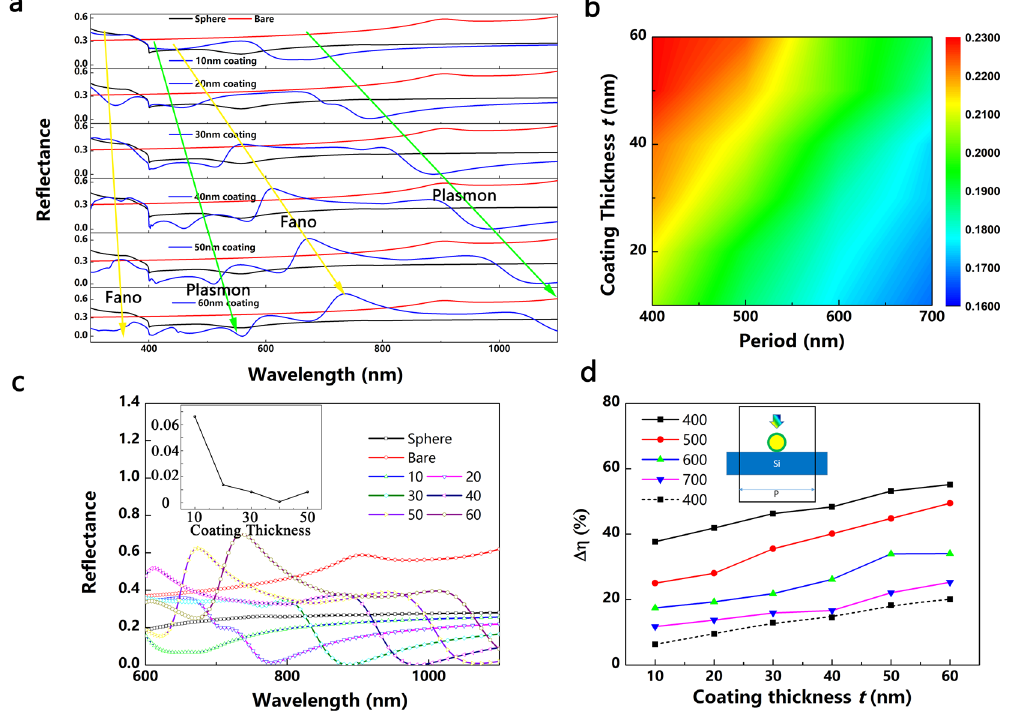
Figure 4. Optical properties and ultimate efficiencies of core-shell nanoparticles with different coating thickness t (Au core/dielectric shell) placed on the front side of a 2 μ m thick Si substrate with different period ( P ). The inner Au core is 120 nm and n is set as 3.4. ( a ) Reflectance spectra of a flat thick Si (2 μ m, bare), a 120 nm Au sphere and core-shell nanoparticles on the 2 μ m thick Si as a function of wavelength, the P is set as 400 nm. ( b ) Ultimate efficiency of core-shell nanoparticles on the 2 μ m thick Si. ( c ) Magnified reflectance spectra of a 2 μ m thick Si, a 120 nm Au sphere and core-shell nanoparticles on the 2 μ m thick Si at long wavelength region; the inset illustrates the minimum reflectance of the 2 μ m thick Si with core-shell nanoparticles locating on the surface. ( d ) Differential efficiency ∆ η between the core-shell nanoparticles on a 2 μ m flat Si and a 2 μ m flat Si without nanoparticles. The dashed line is the differential value of efficiency between the core-shell nanoparticles on a 2 μ m thick Si and a 120 nm Au sphere on a 2 μ m thick Si and the P = 400 nm; the inset is the schematic in